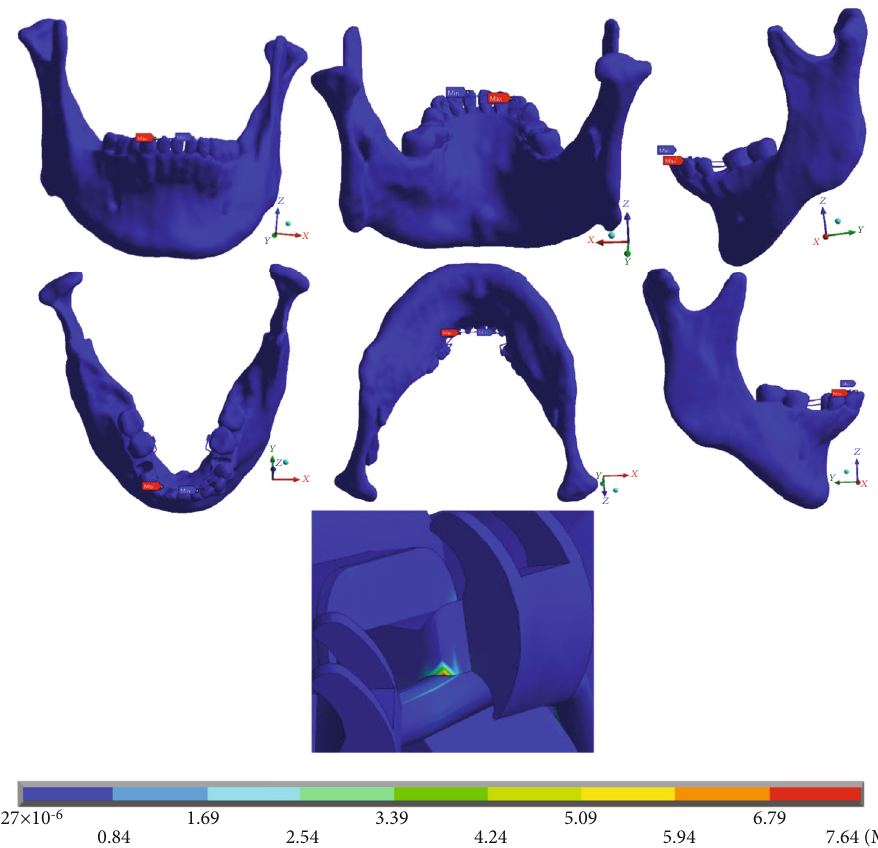
Figure 20: von Mises stresses on the complete system (mandibular bone, dental organs, brackets, and wires). The red marker indicates the maximum stresses, and the blue marker indicates the minor